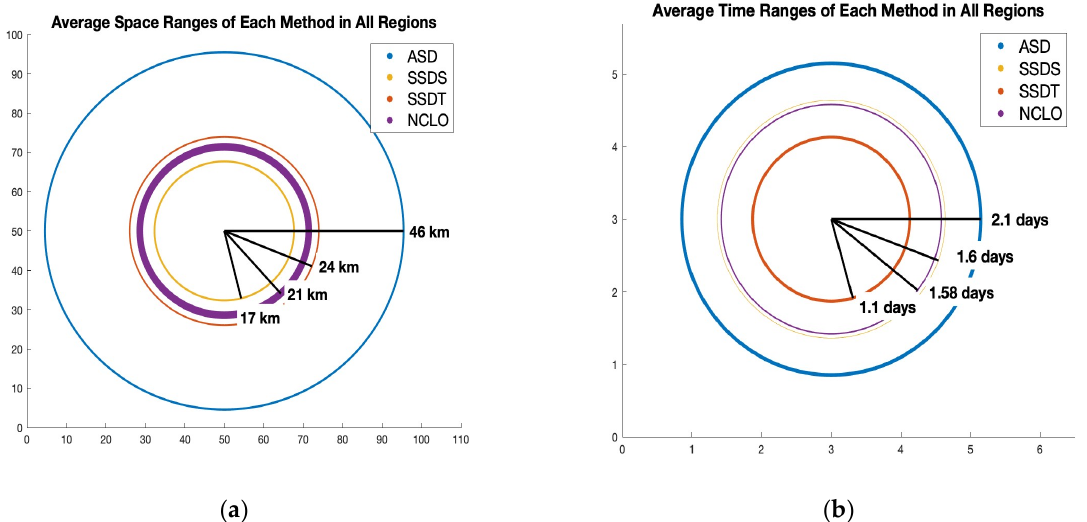
Figure 10. The mean (over all regions) space ( a ) and time ( b ) windows encompassed by each of the four matchup methods using the Aquarius satellite. As indicated by the legend, ASD windows are shown in blue, SSDS in yellow, SSDT in orange, and NCLO in purple. The size of the circles indicates the size of the average window covered. The thickness of the lines is proportional to the standard deviation between the mean space (by a factor of 2) and time (by a factor of 16) ranges calculated for the seven individual regions. Similar figures showing the time and space windows when these methods are applied to SMAP and SMOS are given in the Supplementary Information (Figures S4 and